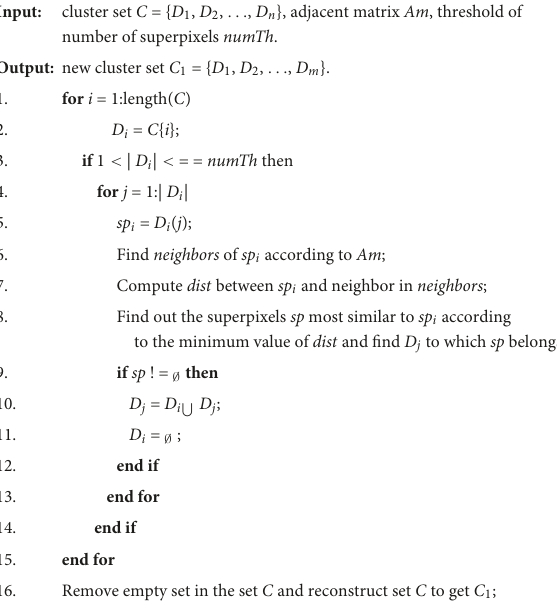
Algorithm 2 : Merging of clusters based on chain propagation